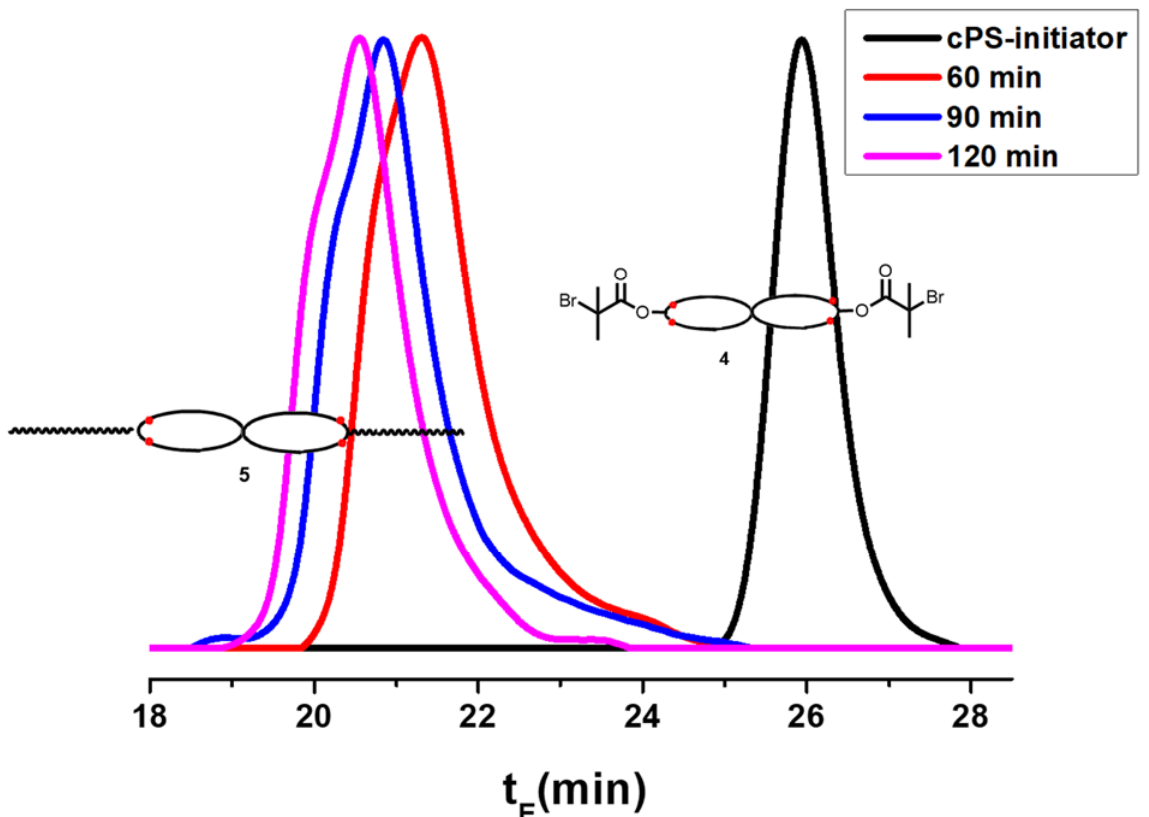
Figure 6. SEC analysis during the chain extension on spirocyclic PS via ATRP of MMA.